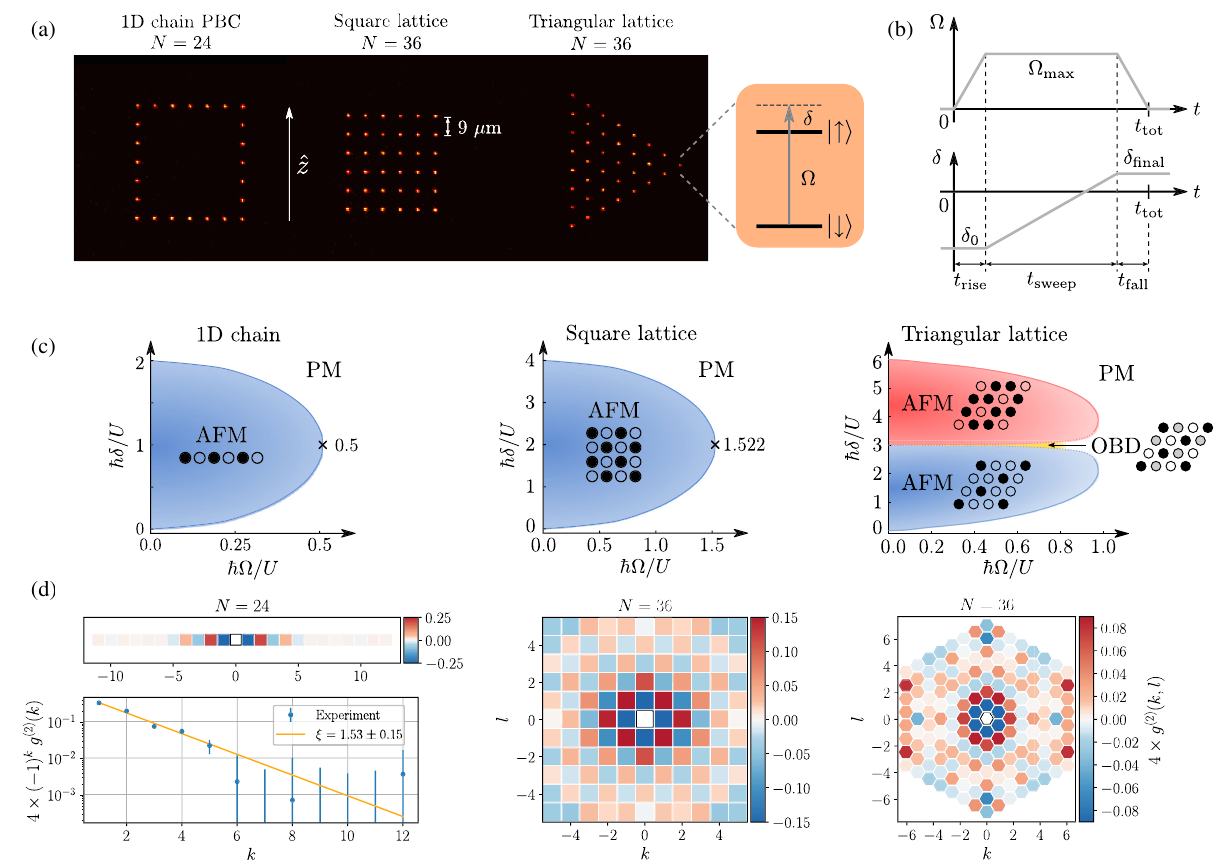
FIG. 1. Studying the AF Ising model on 1d and 2d systems. (a) Examples of single-shot fluorescence images of single-atom arrays used in our experiments: a 24-atom 1d chain with periodic boundary conditions, a 6 × 6 square array, and a 36-atom triangular array. Each atom is used to encode a spin- 1 = 2 , whose internal states j ↑ i and j ↓ i are coupled with Rabi frequency Ω and detuning δ . (b) Time dependence of the Rabi frequency Ω ð t Þ and detuning δ ð t Þ used to probe the buildup of correlations. (c) Sketched ground-state phase diagrams of the Ising model in Eq. (1), in the nearest-neighbor interaction limit, for a 1d chain, a 2d square lattice, and a 2d triangular lattice. In the figure, AFM stands for antiferromagnetic, PM for paramagnetic, and OBD for order by disorder. (d) Typical experimental correlation functions obtained for these geometries (see text). For the 1d chain, the correlation length ξ ¼ 1 . 5 sites (bottom left